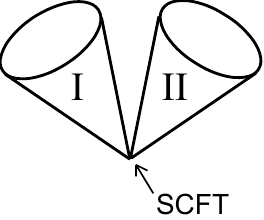
) branches j (cid:20) j +1